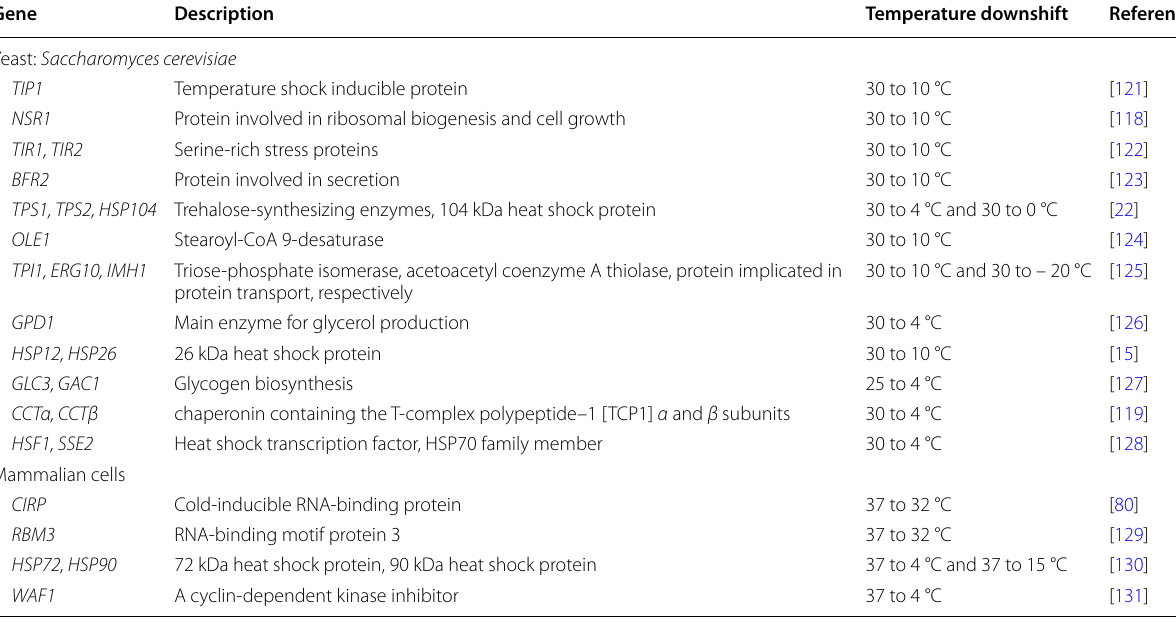
Table 3 Some genes upregulated by cold stress in S. cerevisiae and mammalian cells